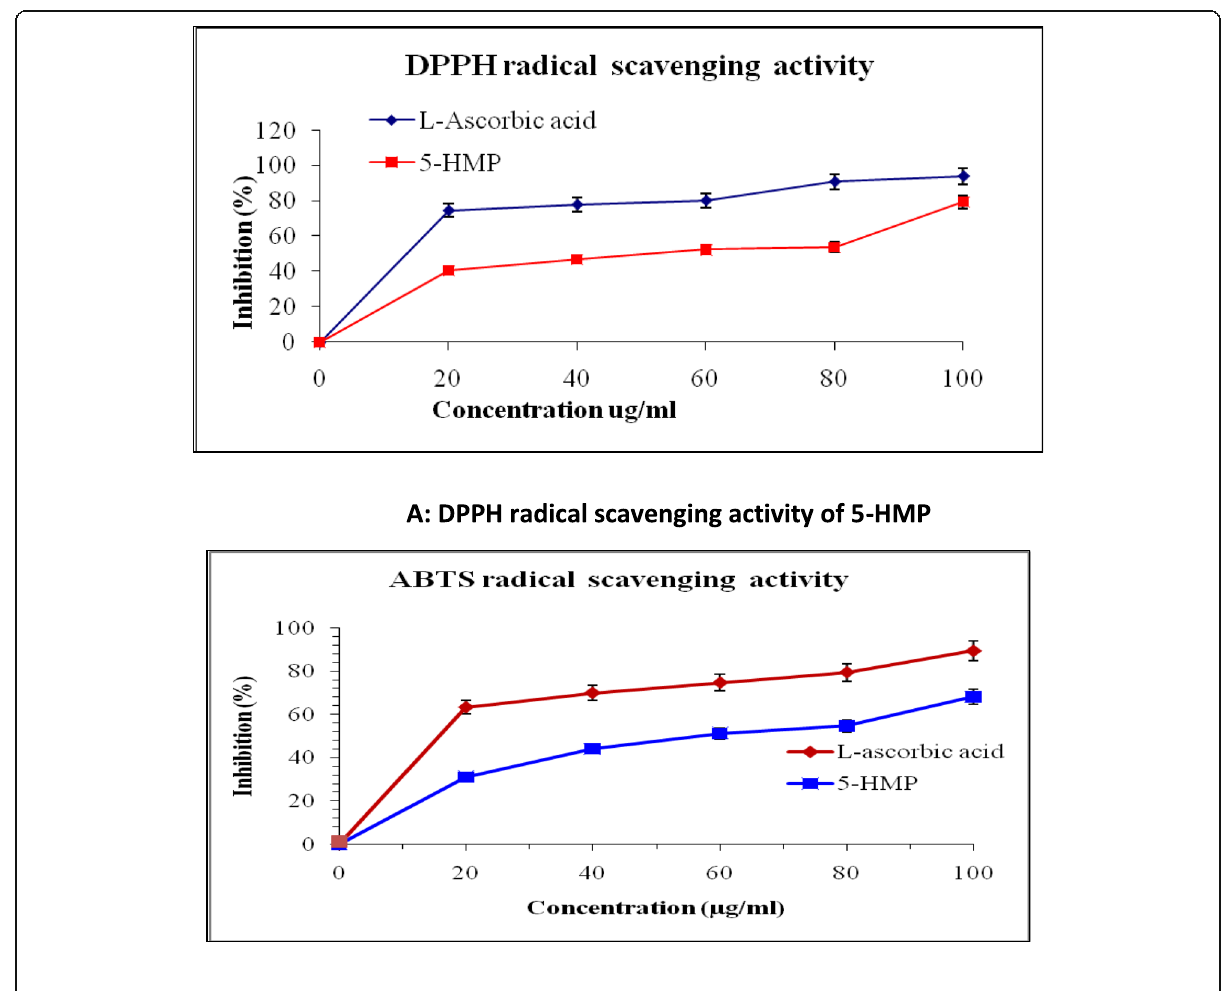
Fig. 2 a DPPH radical scavenging activity of 5-HMP. b ABTS radical scavenging activity of